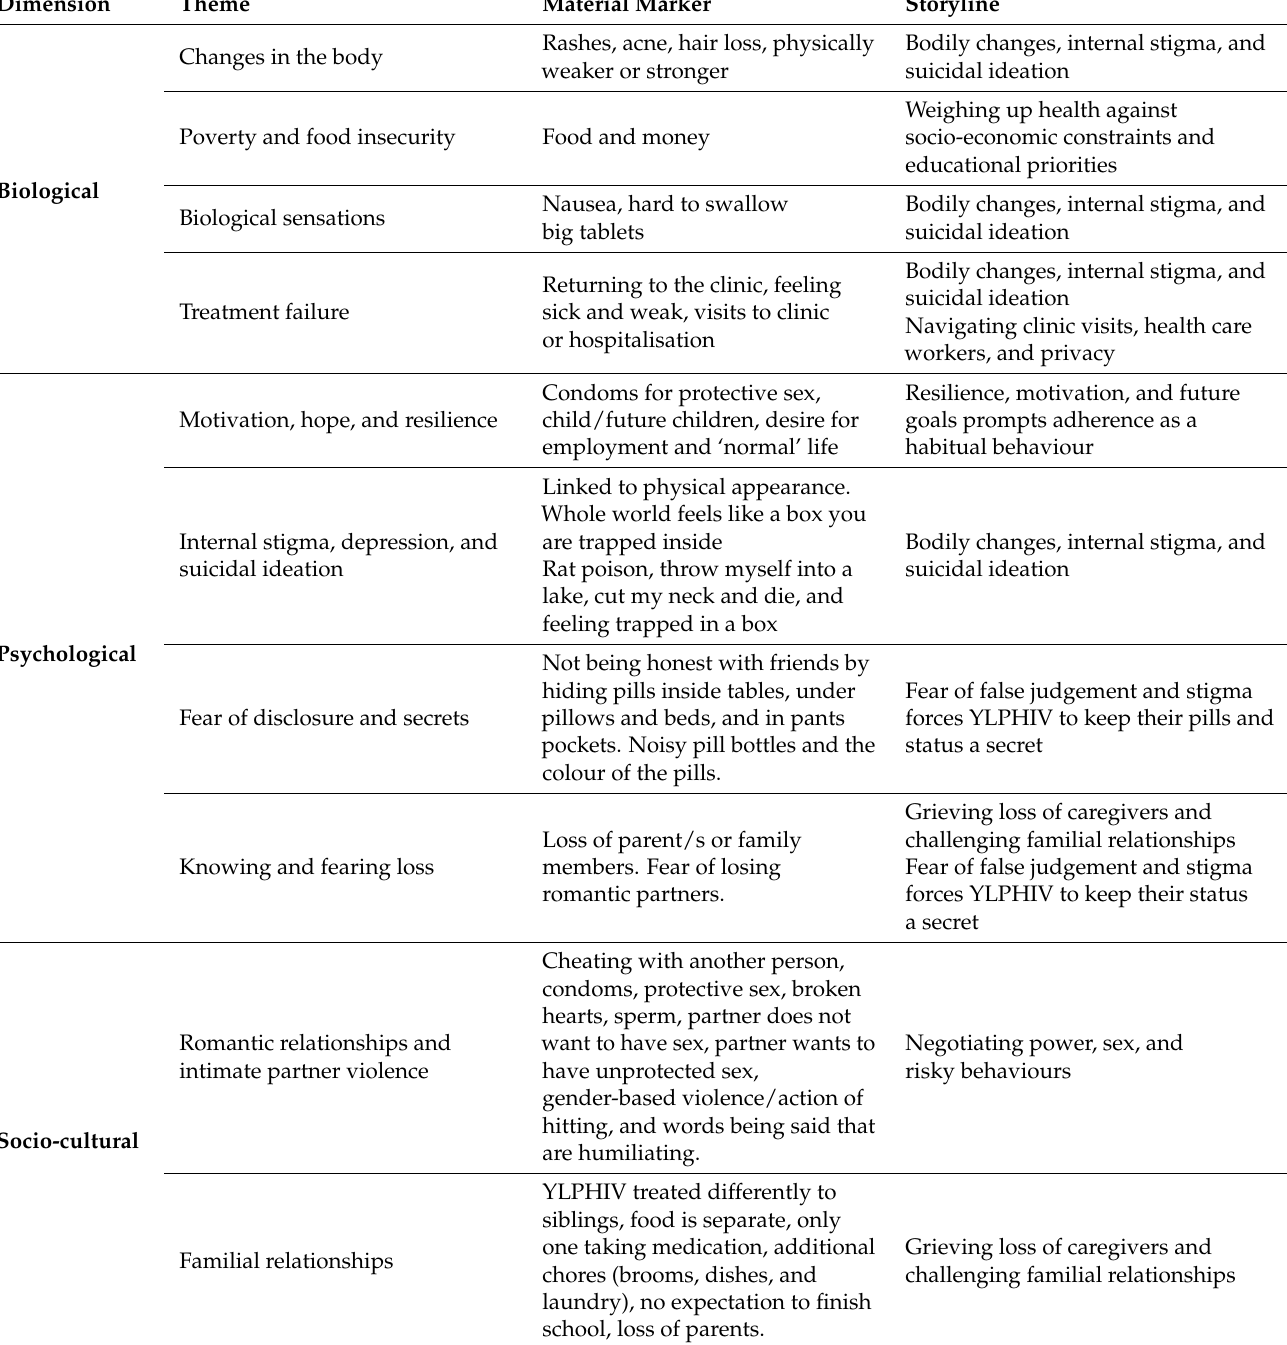
Table 1. Themes, material markers, and